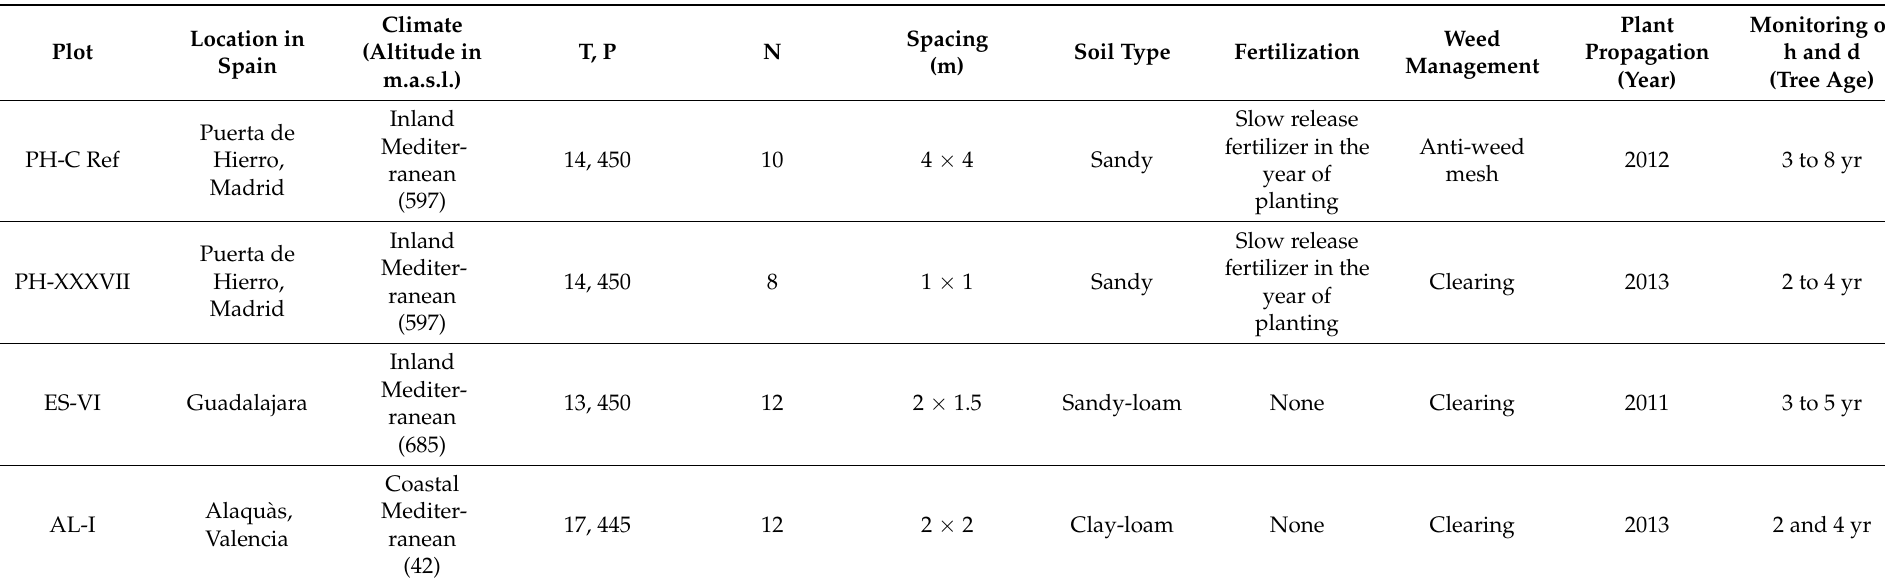
Table 1. Specifications of the experimental plots used to estimate wood yield of Ademuz clone. T = average annual temperature ( ◦ C); P = average annual precipation (mm); N = number of replicates; h = height; d =